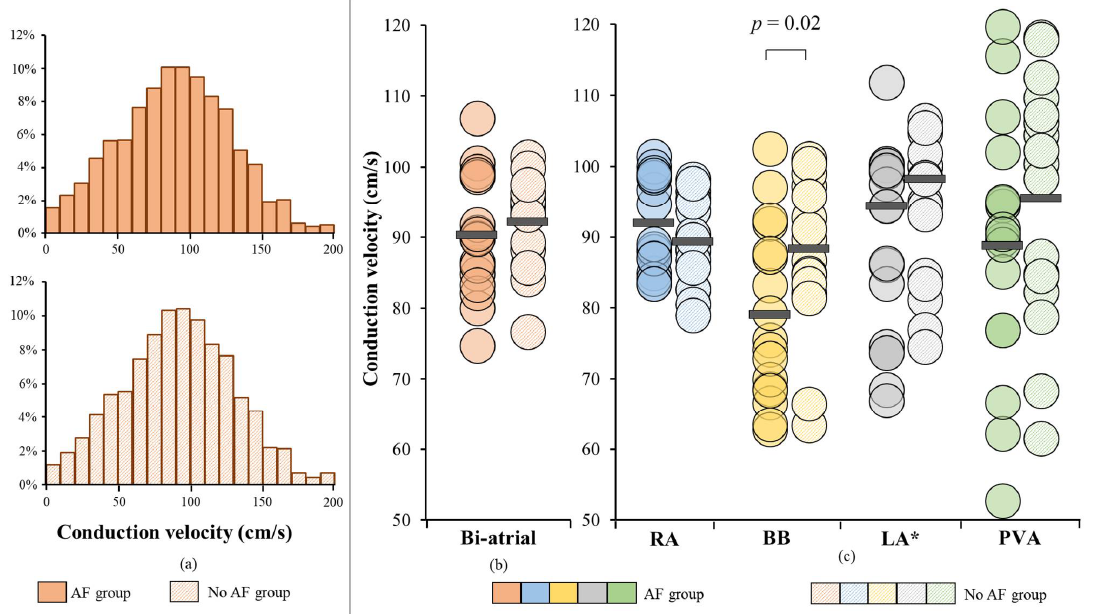
Figure 2. CV in patients with and without a history of AF. ( a ) biatrial CV histograms of patients with and without a history of AF; ( b ) biatrial median CV displayed for each patient ( c ) median CV displayed for each patient per region separately. *Non-normally distributed. cm/s = centimeter/second; CV = conduction velocity; AF = atrial fibrillation; BB = Bachmann’s Bundle; LA = left atrium; PVA = pulmonary vein area; RA = right atrium.